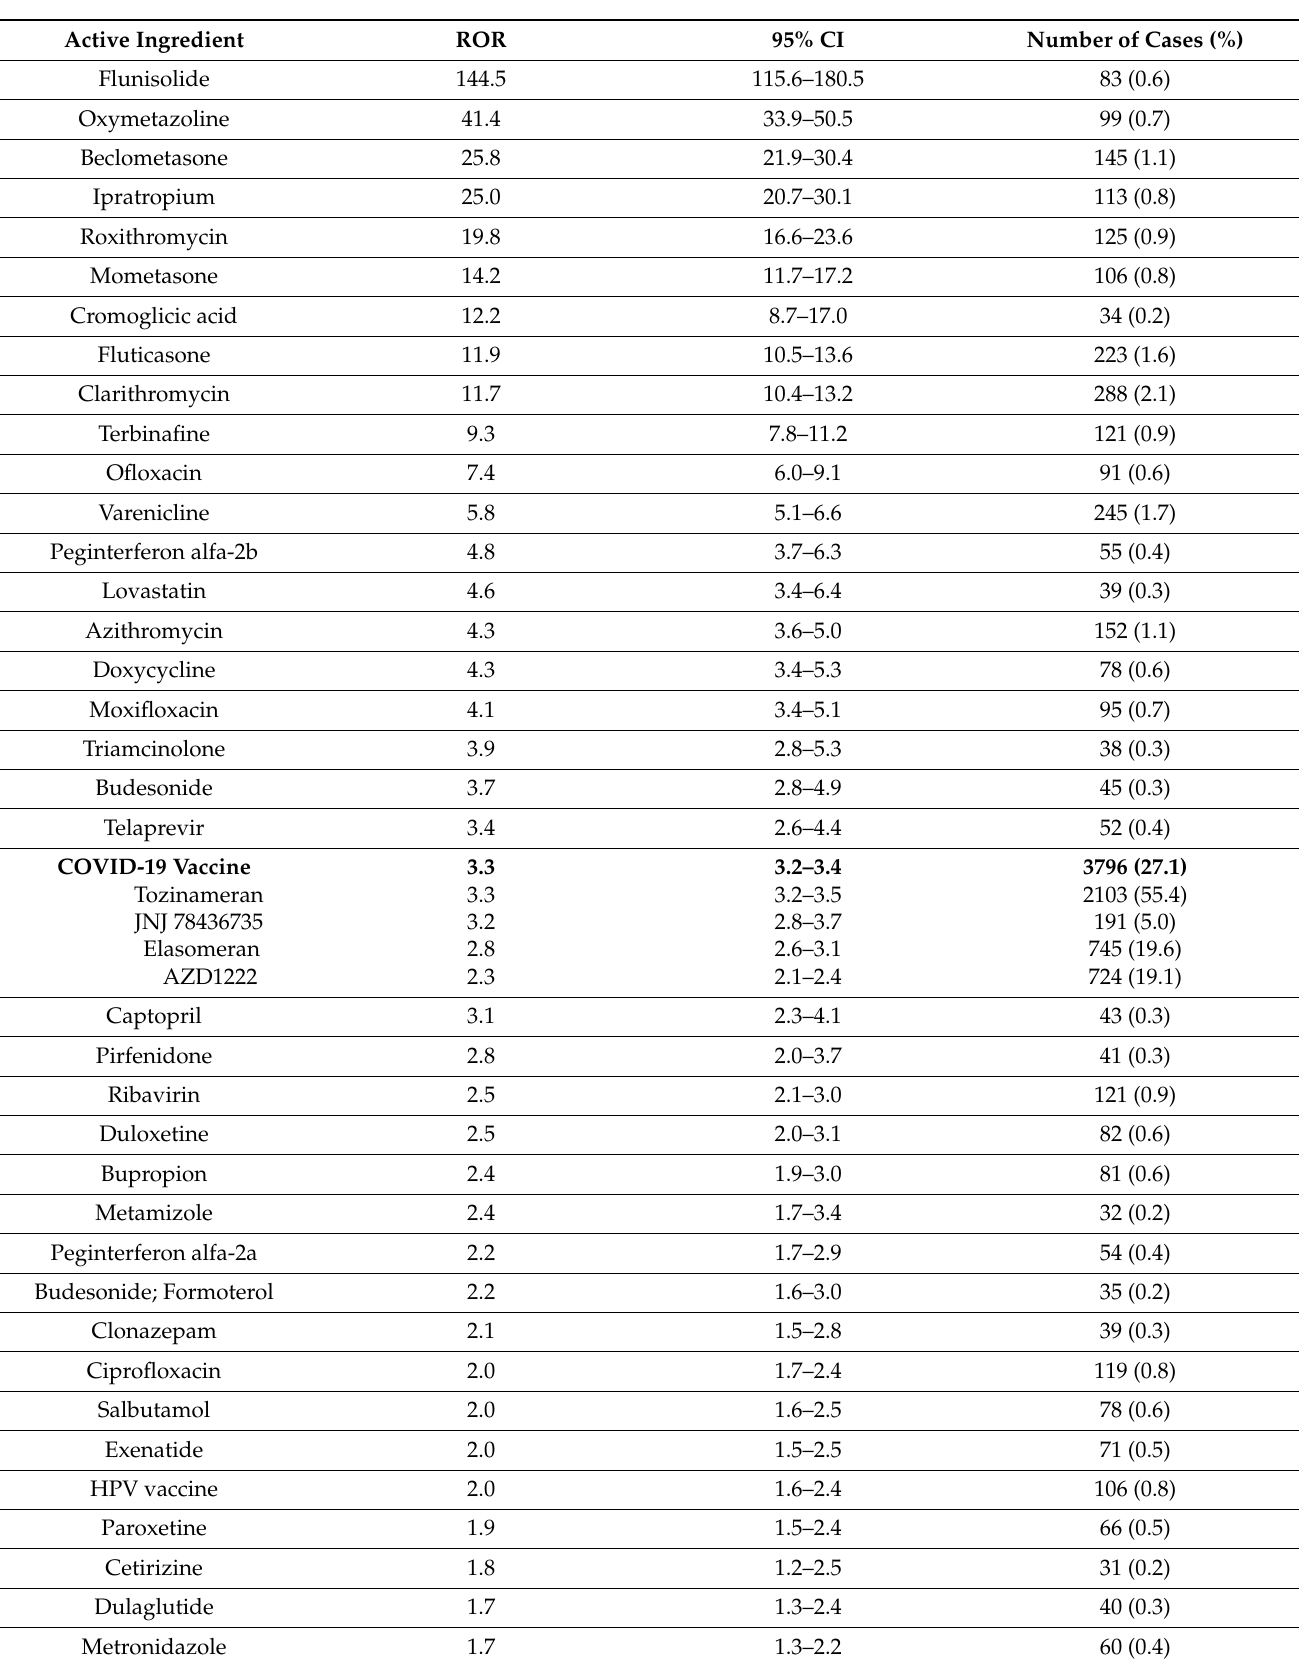
Table 3. Disproportionality analysis for reports of